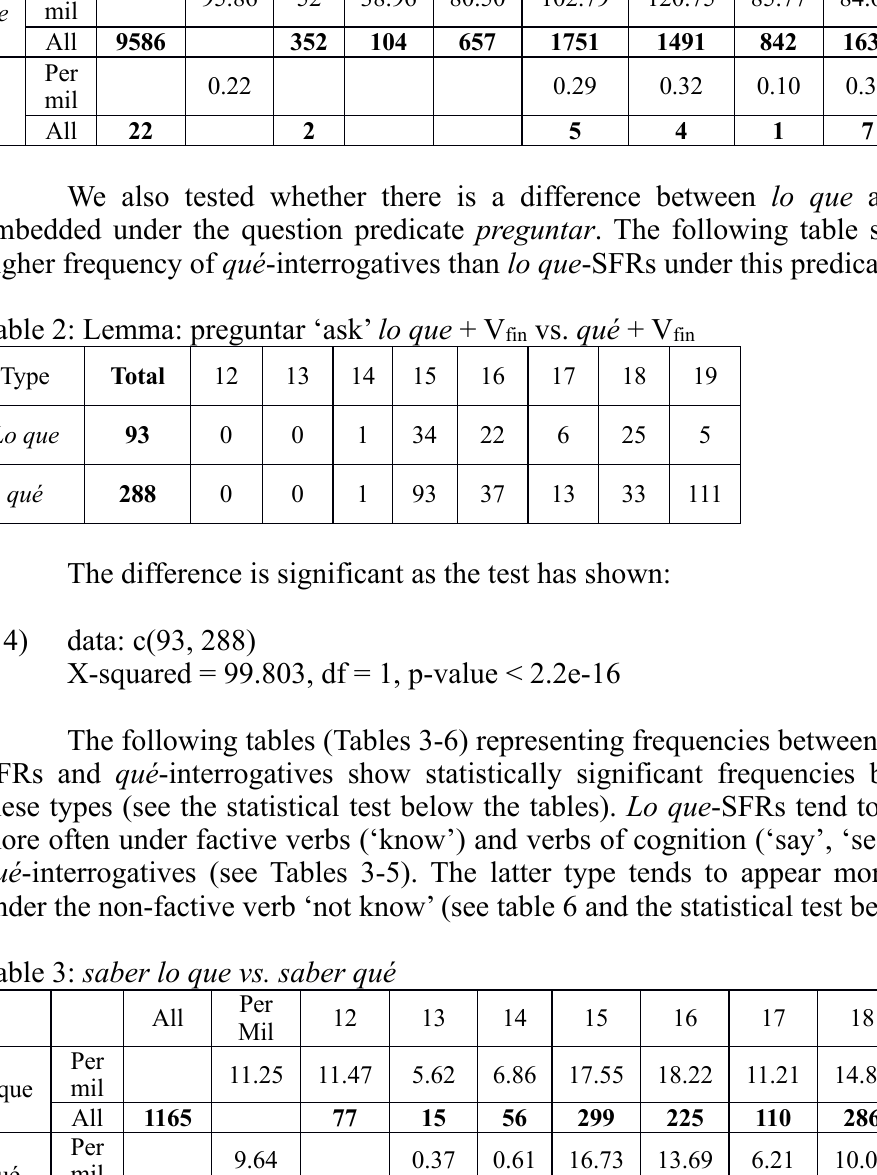
vs. es qué + V fin